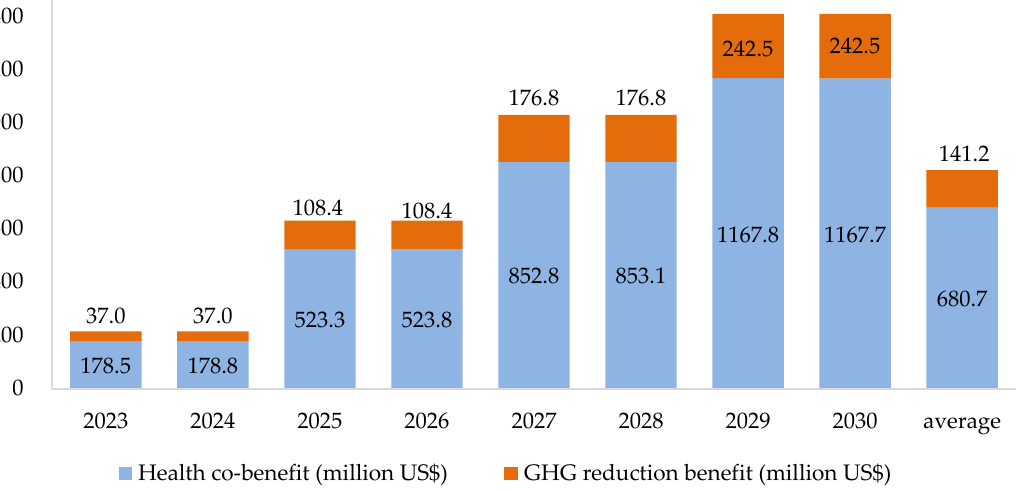
Figure 5. Simulated GHG reduction benefits and health co-benefits for scenario 1 in 2023–2030.